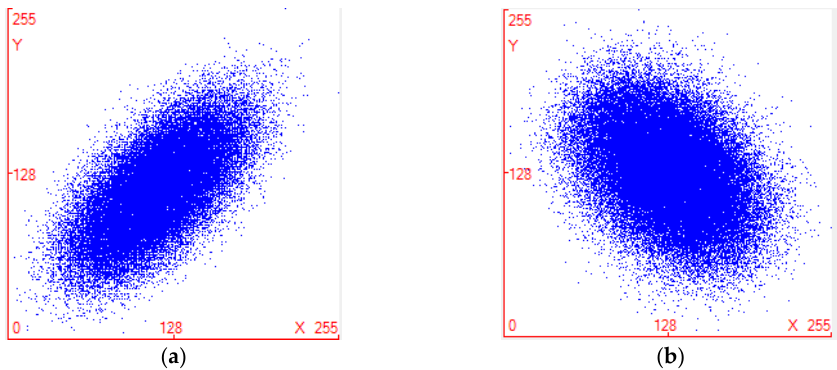
Figure 2. ( a ) Correlation distribution diagram of image scrambling encryption algorithm; ( b ) Correlation distribution of improved image scrambling encryption algorithm.